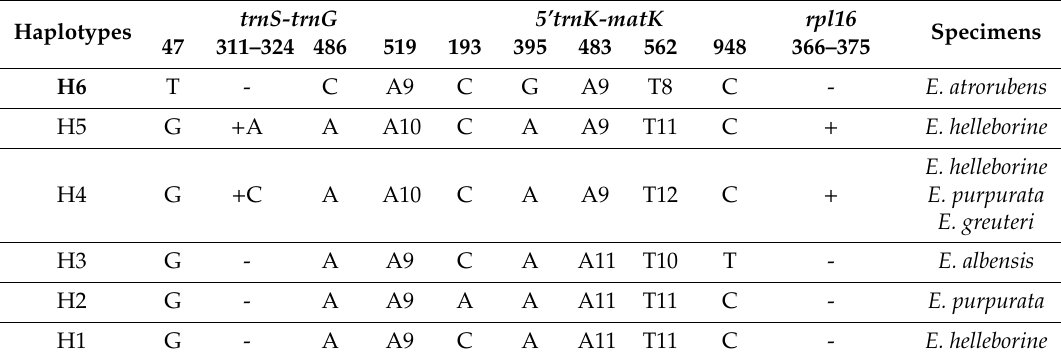
Table 2. Alignment of plastid haplotypes of all analyzed taxa and regions. ‘+’ indicates fragment duplication. Haplotypes trnS-trnG